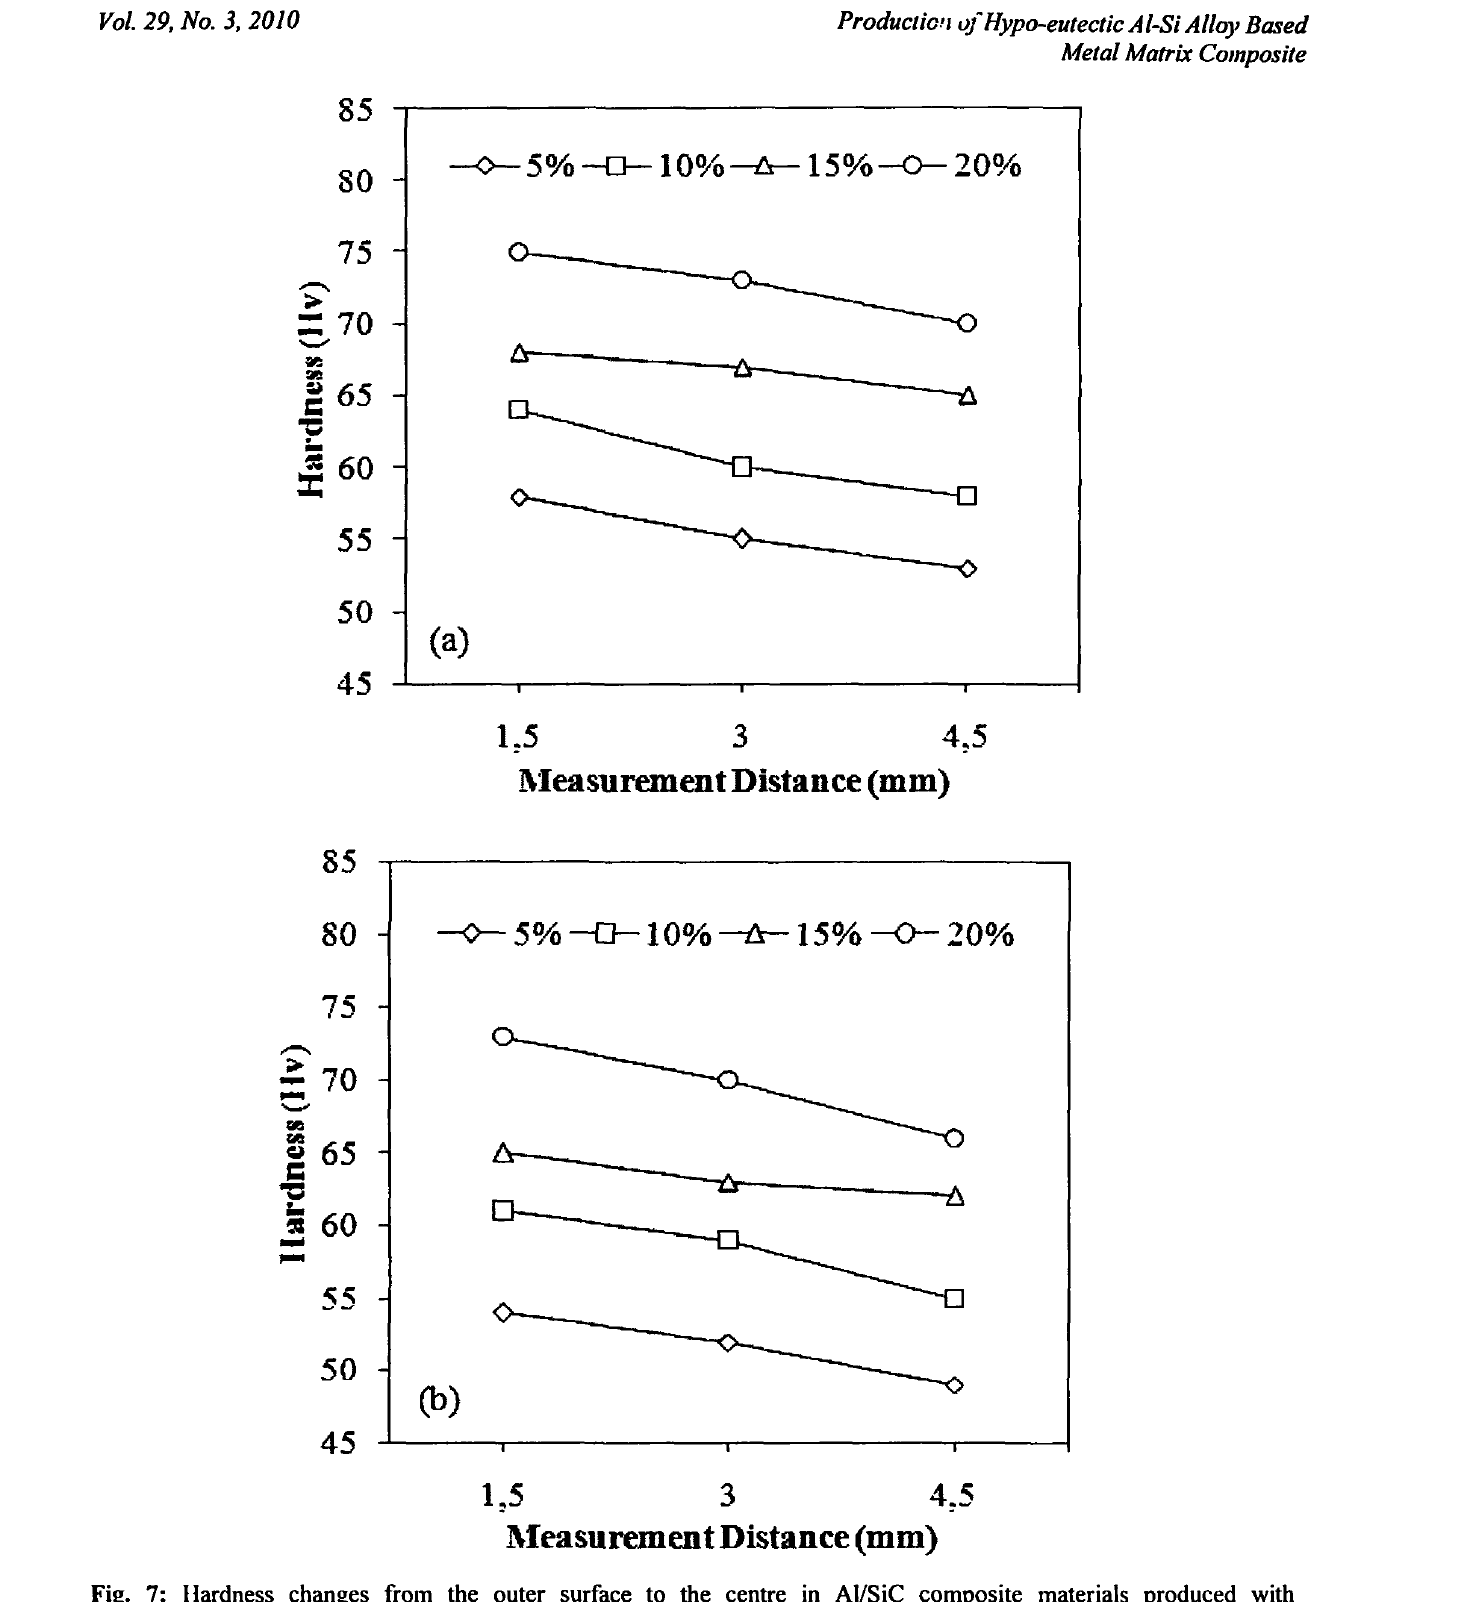
Fig. 7: Hardness changes from the outer surface to the centre in AI/SiC composite materials produced with thixomoulding at 863 Κ (a) and 873 K (b)